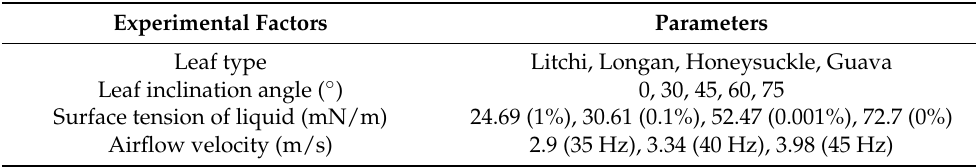
Table 4. Factors and parameters of the spray deposition experiment.